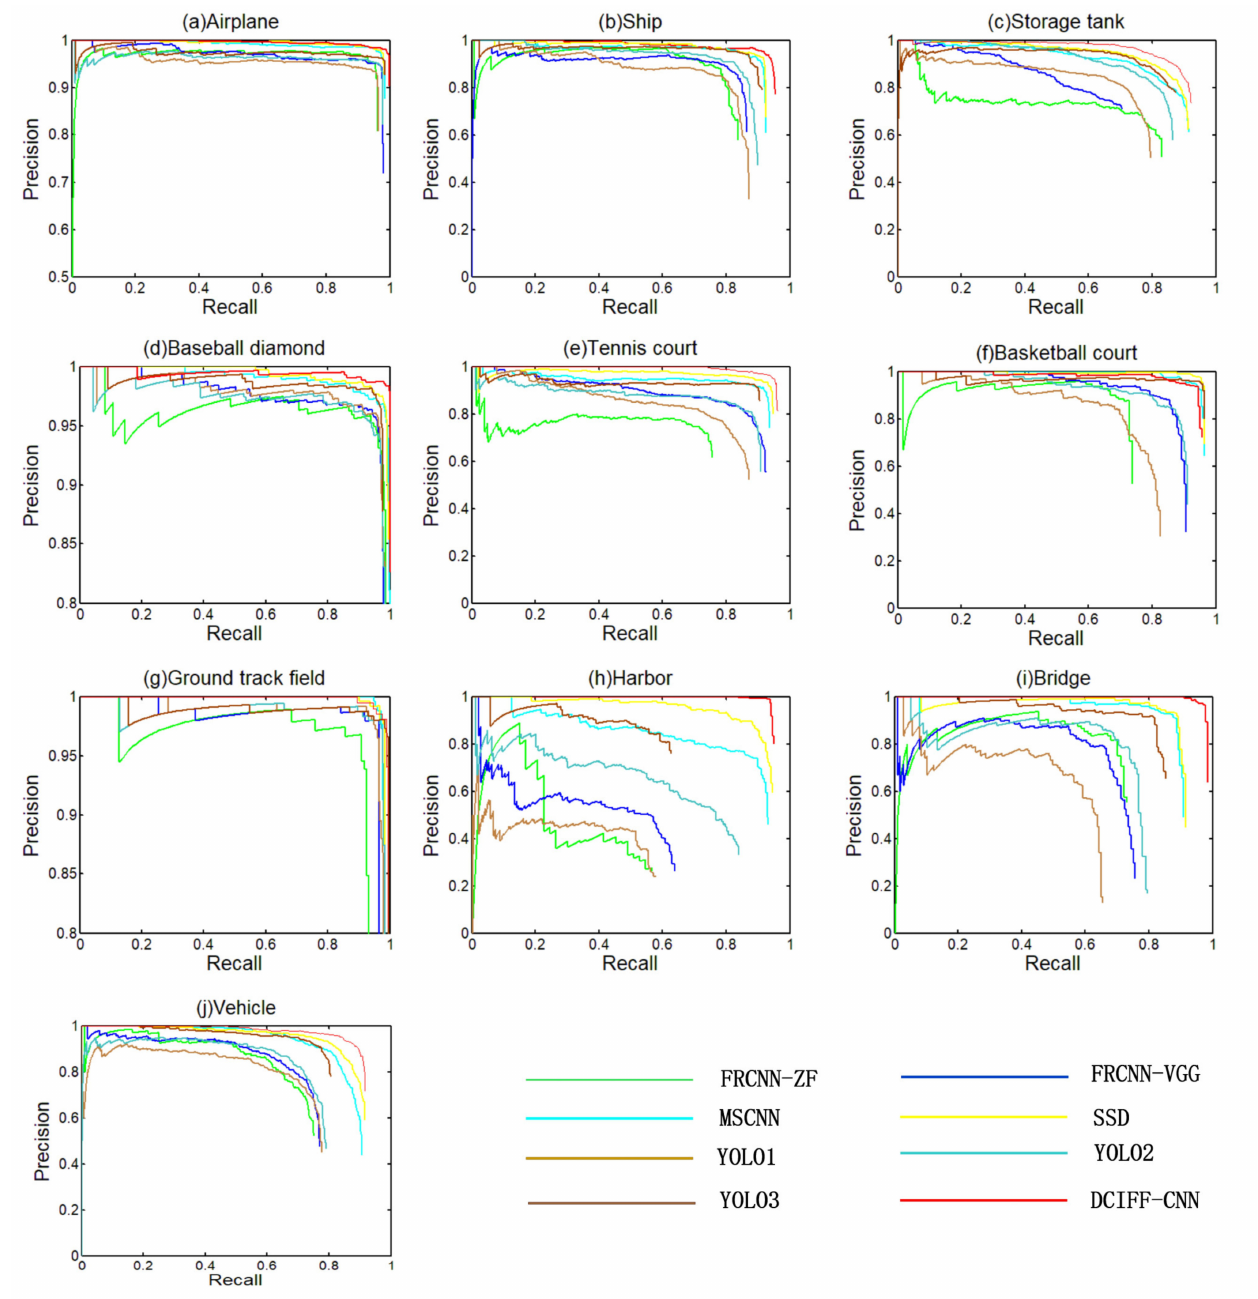
Figure 11. The precision-recall curves (PRCs) of the proposed method and other compared methods. ( a ) Airplane; ( b ) Ship; ( c ) Storage tank; ( d ) Baseball diamond; ( e ) Tennis court; ( f ) Basketball court; ( g ) Ground track field; ( h ) Harbor; ( i ) Bridge; ( j )